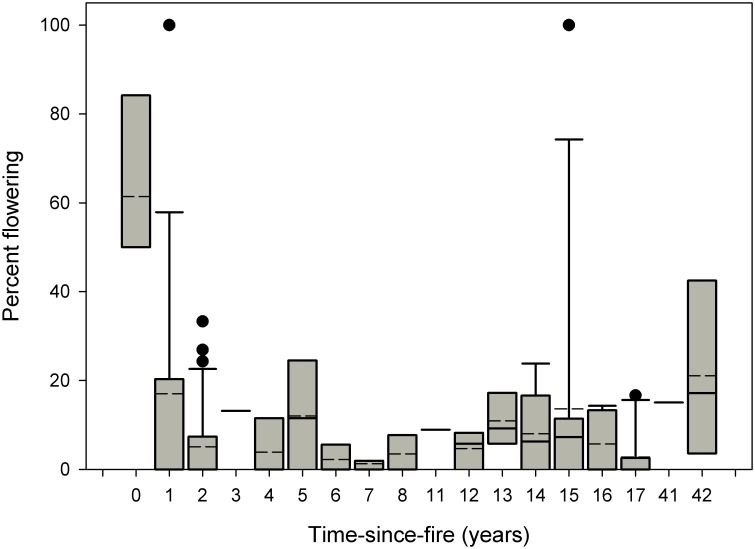
Percent flowering in relation to time-since-fire (in years) for eight subpopulations of E. rosescens.Boxplots show mean (dashed line) and median (solid line). Black circles represent outliers.